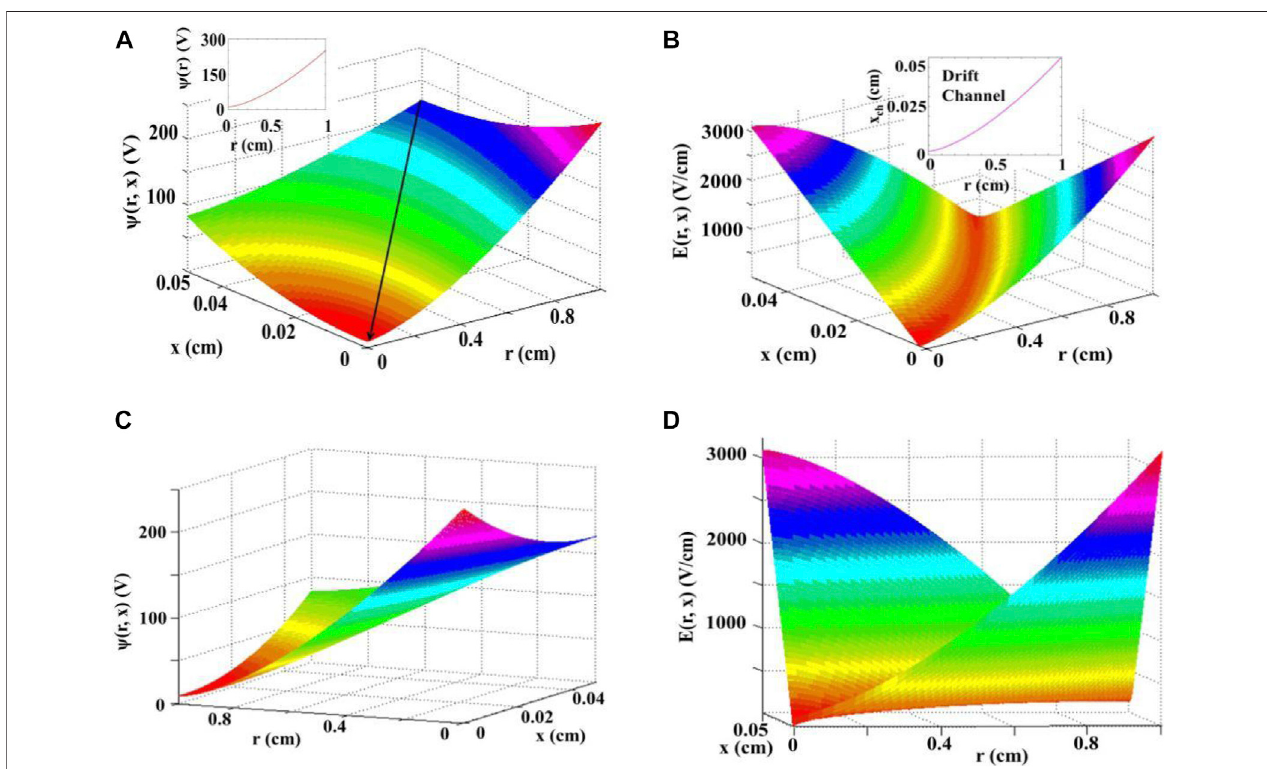
FIGURE 3 | 3D simulations of electric potential distribution and electric fi eld distribution of DSSH-SDD. (A) and (C) are the 3D electric potentials of the silicon drift detectoratdifferentviewingangles; (B) and (D) arethe3Delectric fi elddistributionsoftheSDD,andthedriftchanneliswithintheSDDbody,pointingtowardstheanode